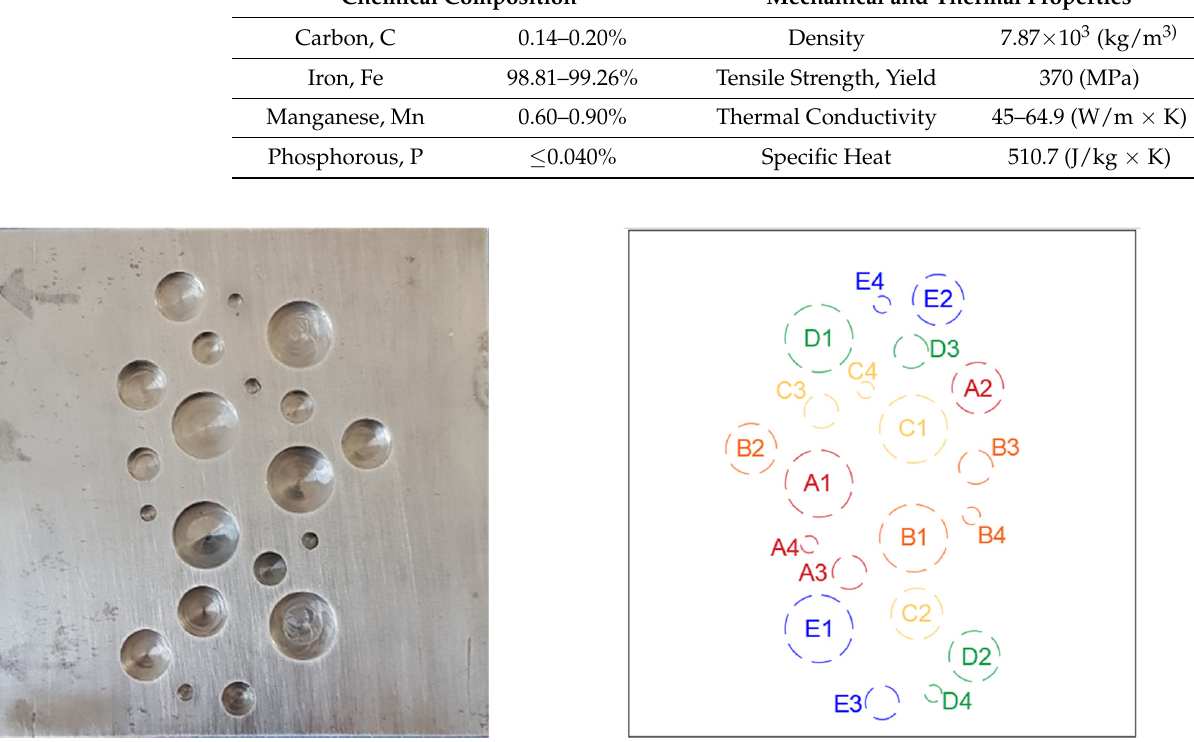
Table 1. AISI 1018 mild steel mechanical and thermal properties.